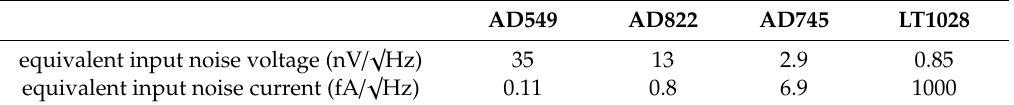
Table 2. Typical low-noise